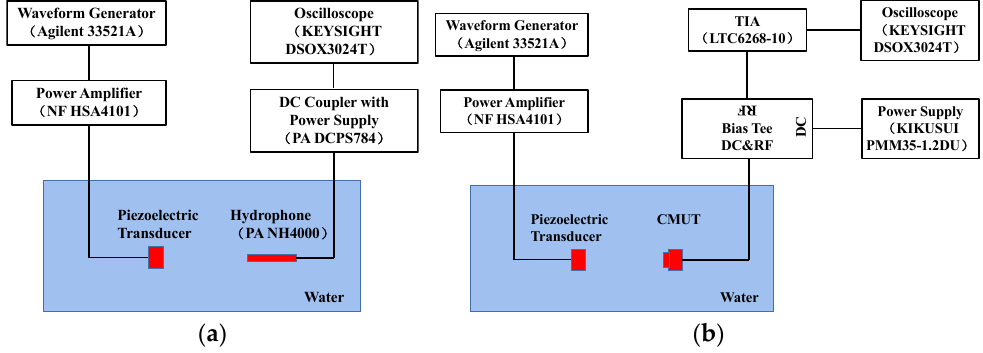
Figure 17. ( a ) Schematic of measurement setup of the CMUT receiving performance; ( b ) Photograph of the measurement setup.